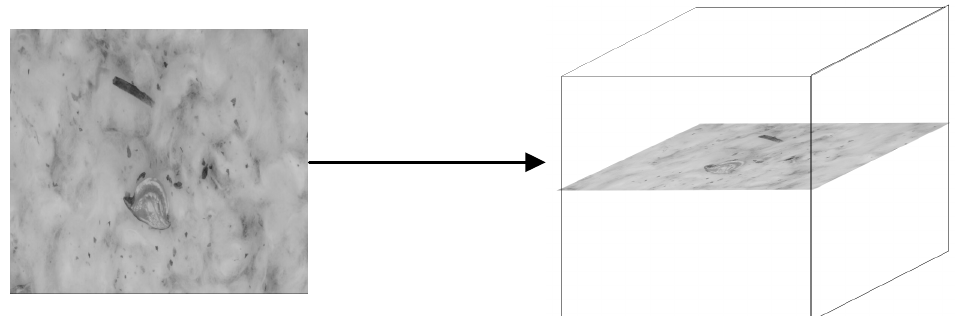
Figure 13. Schematic diagram of image information expansion.